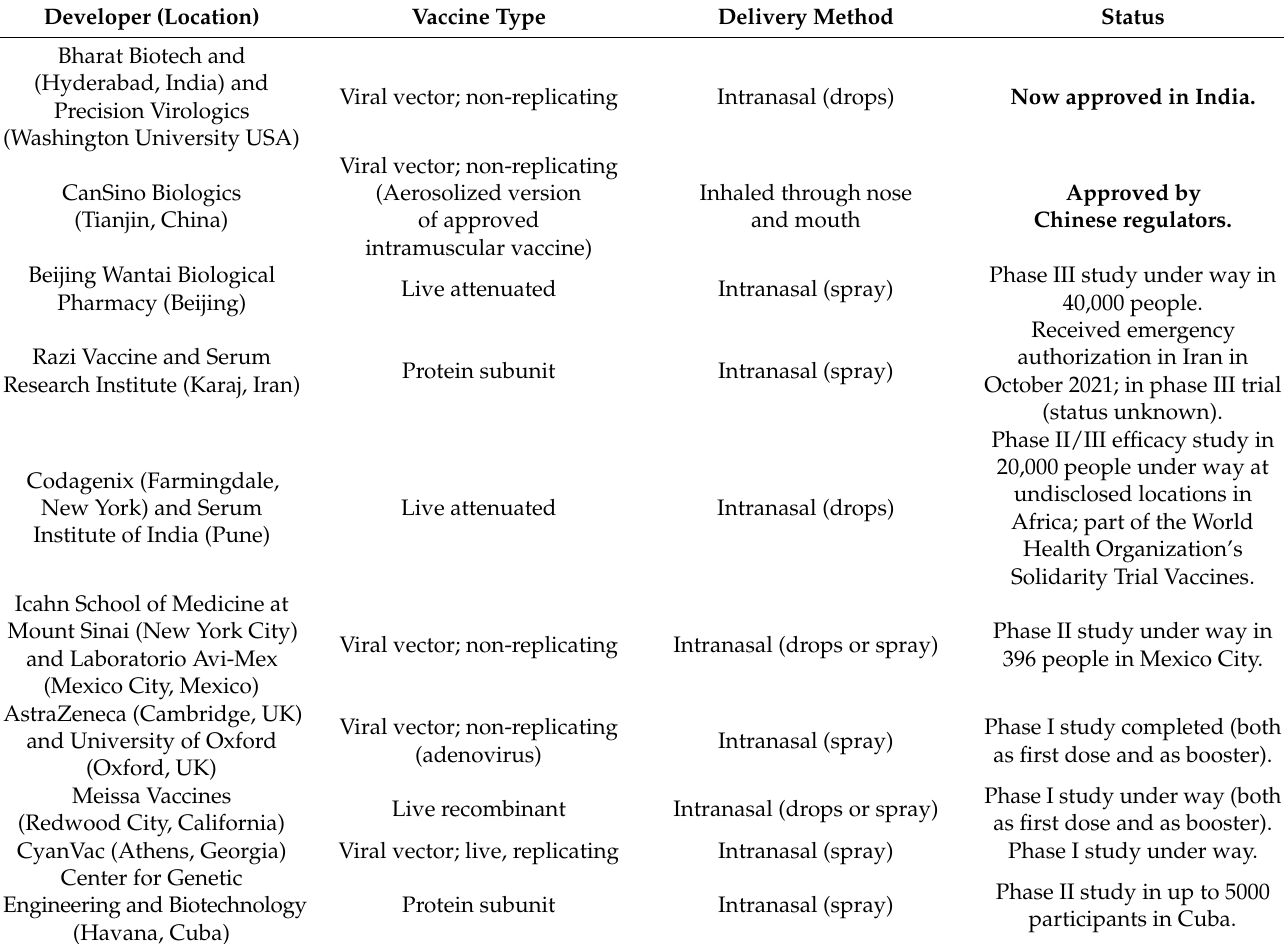
Table 2. Some of Intranasal COVID-19 vaccines in development